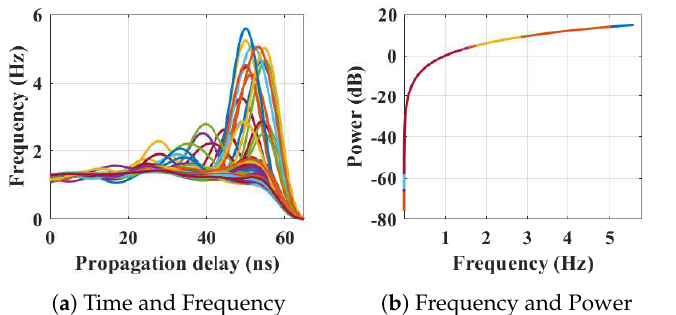
Figure 6. The relationship between propagation delay, activity frequency, and received power from the radar responses obtained while the person is using the microwave in the kitchen has been considered as C3 in classification phase.